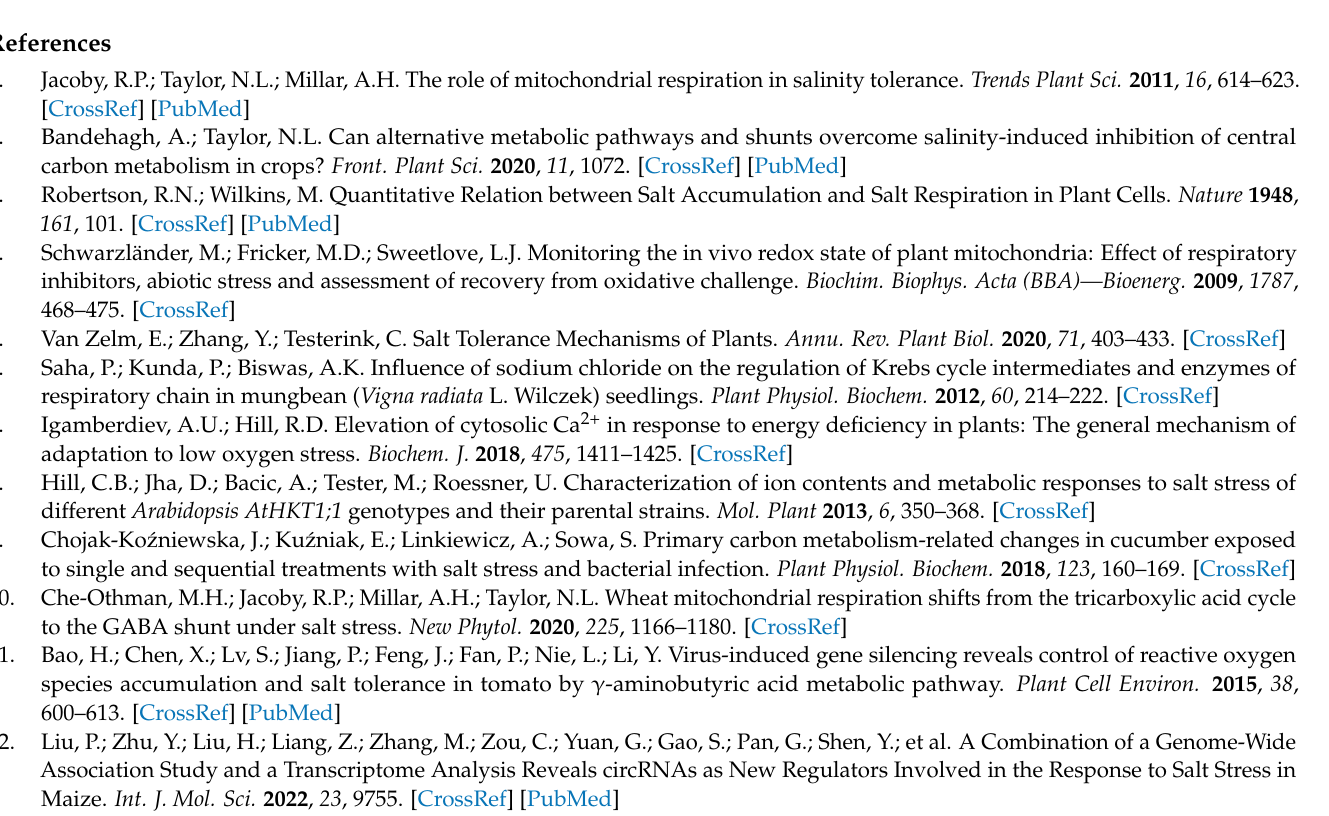
Table S2: Primers to the promoter of the succinic semialdehyde dehydrogenase gene for methyl- specific PCR. Table S3: Primers to the promoter of the succinate dehydrogenase gene for methyl- specific